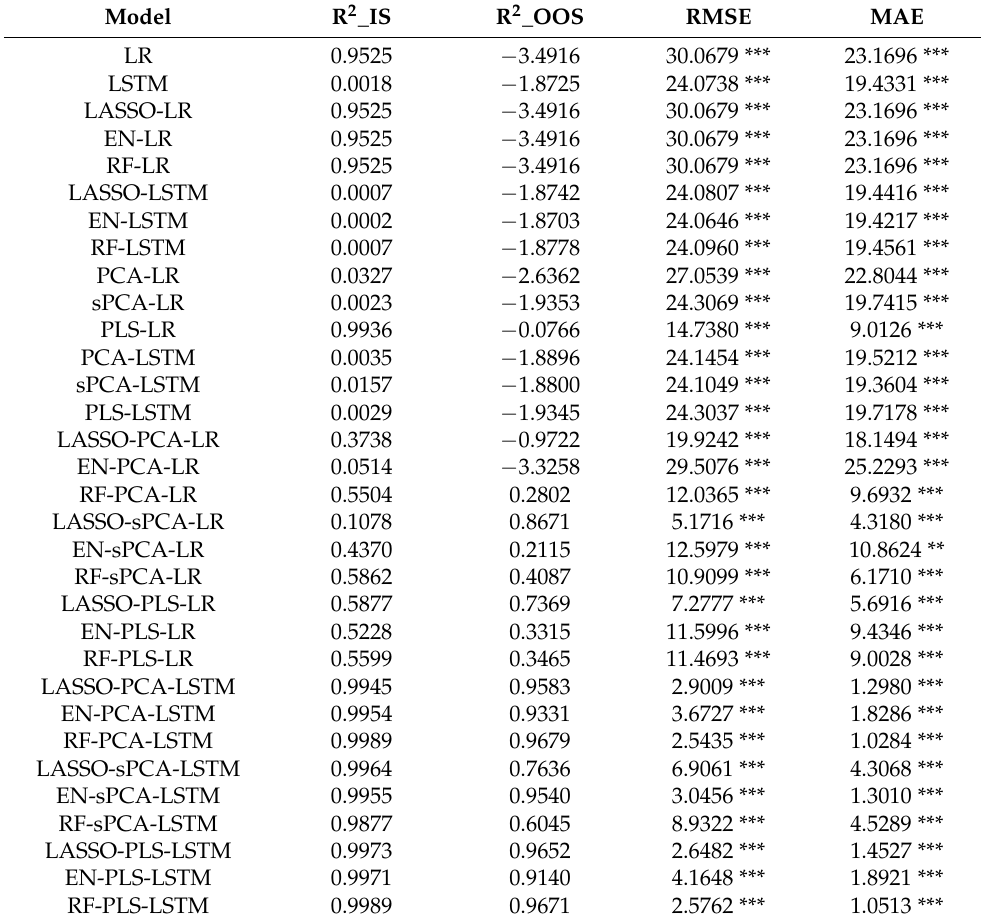
Table 12. Forecast results for different dataset divisions.